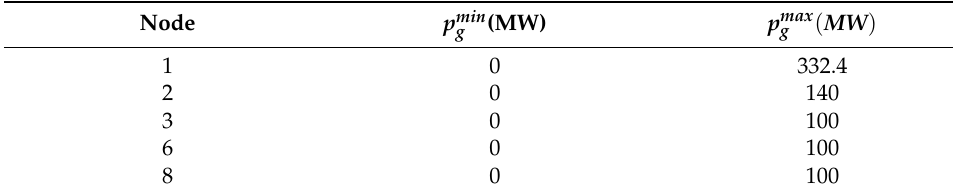
Table 3. Generator node parameters.